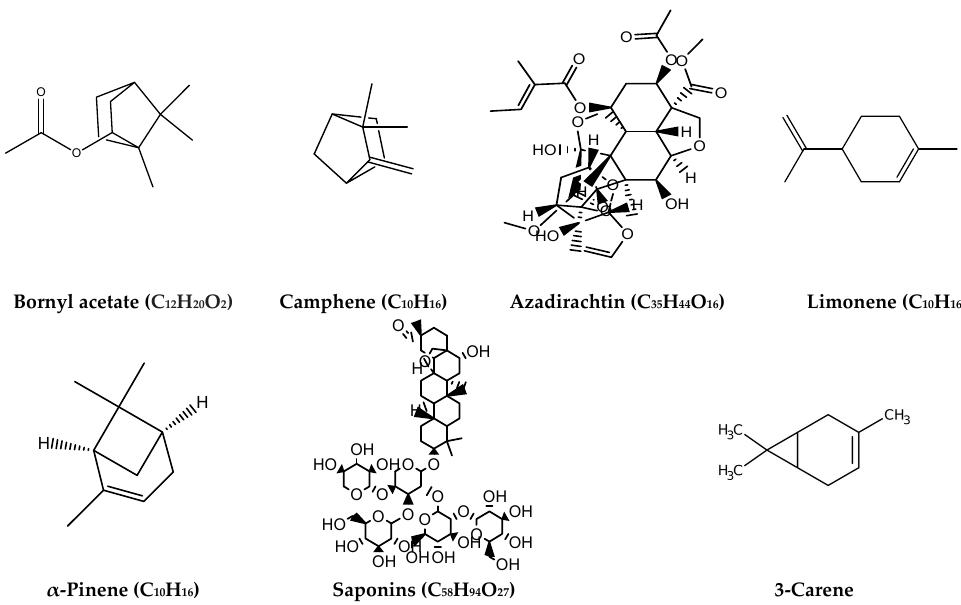
Figure 1. Chemical structures of some common plant terpenoids.